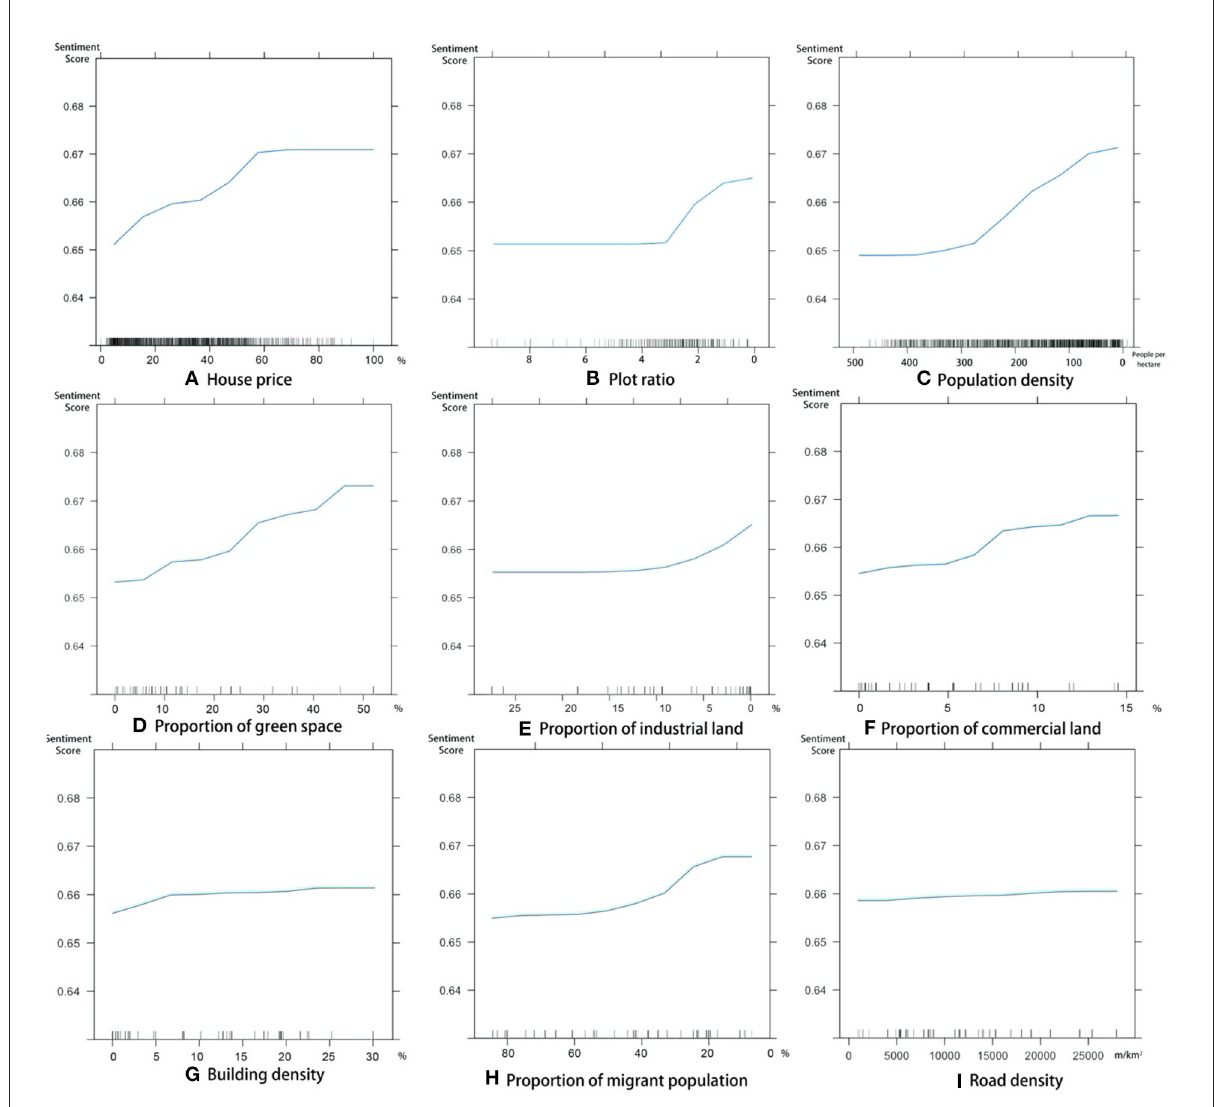
FIGURE6 Non-linear correlation between sentiments and different independent variables. [ (A) land value (percentile); (B) plot ratio*; (C) population density*; (D) proportion of green space; (E) proportion of industrial land*; (F) proportion of commercial land; (G) building density; (H) proportion of the migrant population*; (I) road density]. *The variable is negatively correlated with sentiments; therefore, we plotted the growth of the built environment in the positive direction of the horizontal